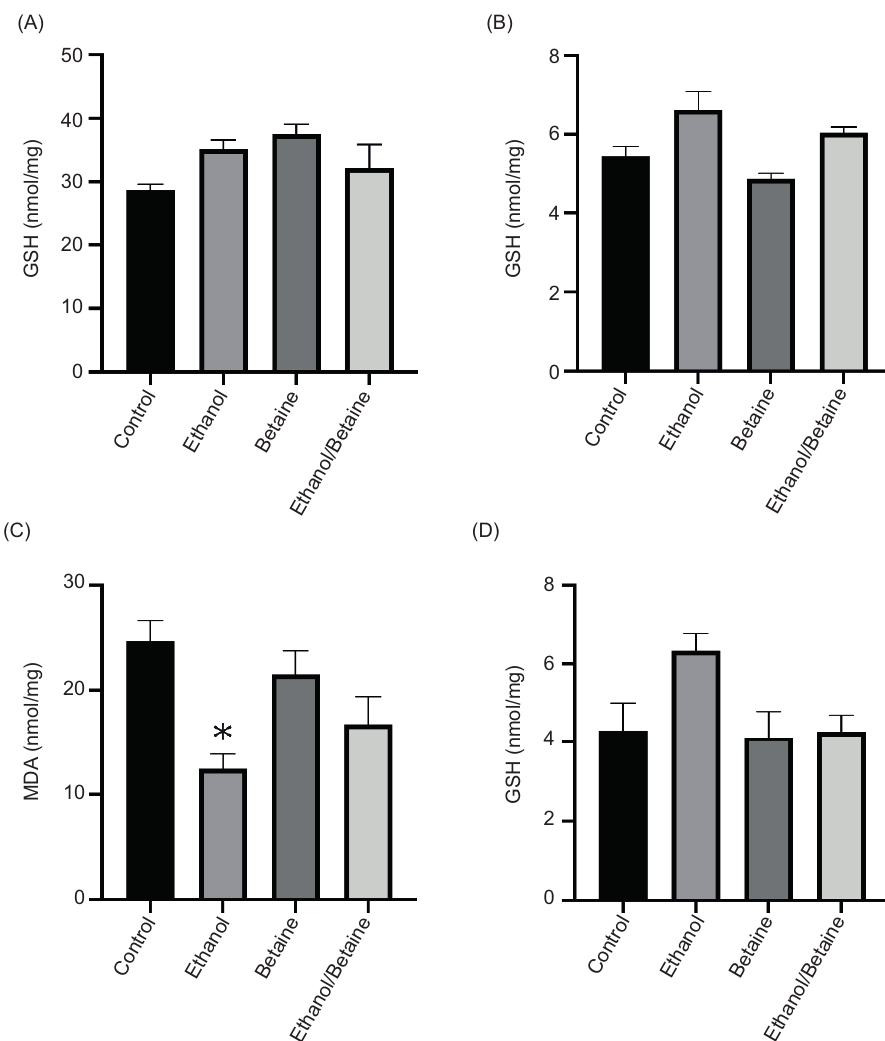
Figure 2. The effect of betaine on ethanol-induced changes in (A) cytosolic GSH levels, (B) mitochondrial GSH levels, (C) cyto- solic MDA formation, and (D) mitochondrial MDA formation. The “betaine” experimental animals were given drinking water containing 2% betaine (w/v) for 6 days. Saline (0.15 mol/L NaCl) or ethanol (75 mmol/kg bodyweight) was administered i.p. on day 7, and 24 h later the animals were sacrificed. Liver mitochondrial and cytosolic fractions were prepared as described in the methods. Values are expressed as mean ± SEM (n = 3–4). *P < 0.05 compared to